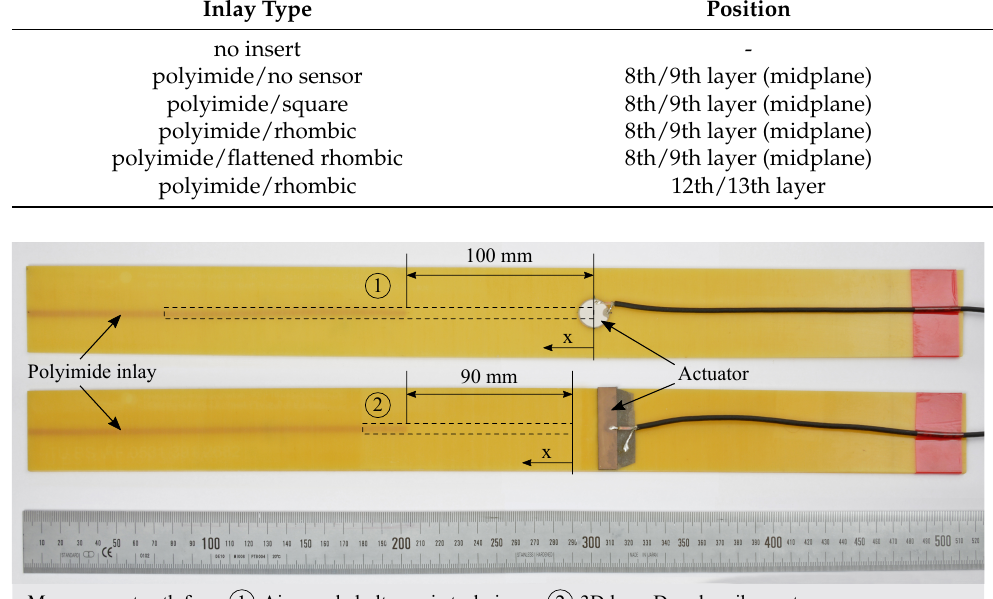
Figure 3. GFRP strip specimens with scale, visible polyimide inlay (orange, left) as well as rectangular ( top ) and circular ( bottom ) PZT actuators. For the exact dimensions and setup cf. Figure 2. In addition, the measurement paths and coordinates for the measurements described in Section 2.3 are